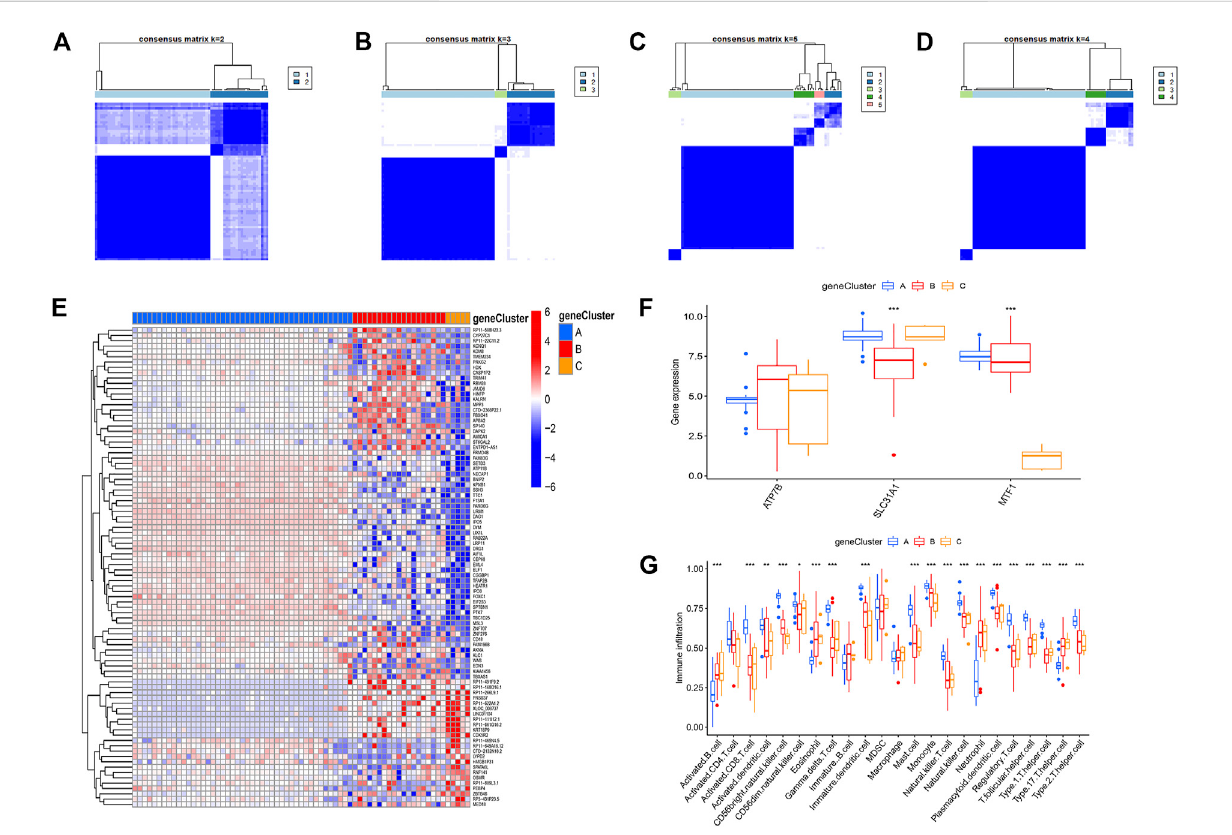
FIGURE 7 Theconsensusclustering ofthe90cuproptosis -relatedDEGsinchildhoodasthma. (A – D) Consensusmatrices ofthe90cuproptosis-relatedDEGs for k = 2 – 5. (E) Expression heat map of the 119 cuproptosis-related DEGs in gene clusterA, gene clusterB and gene clusterC. (F) Differential expression histogram of the 3 signi fi cant cuproptosis regulators in gene clusterA, gene clusterB and gene clusterC. (G) Differential immune cell in fi ltration between gene clusterA, gene clusterB and gene